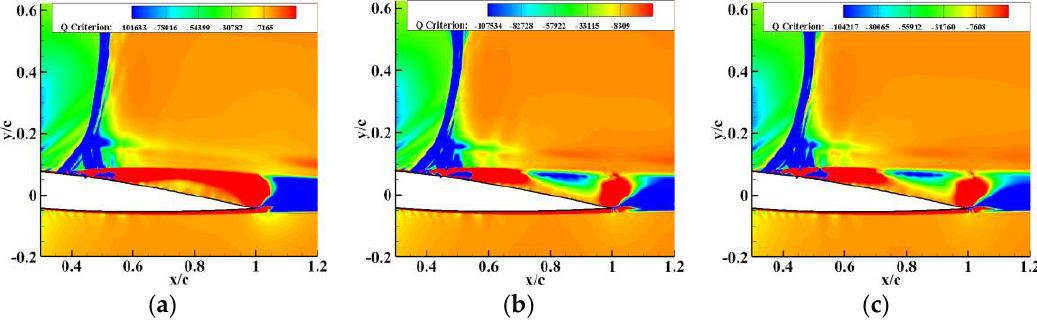
Figure 24. Q-criterion results for the “ 46% x/c ” case. (a) Maximum lift; (b) median lift; and (c) minimum lift.